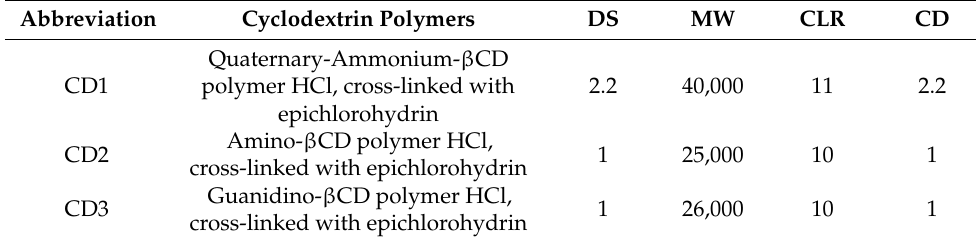
Table 1. The chemical properties of CD polymers used in this